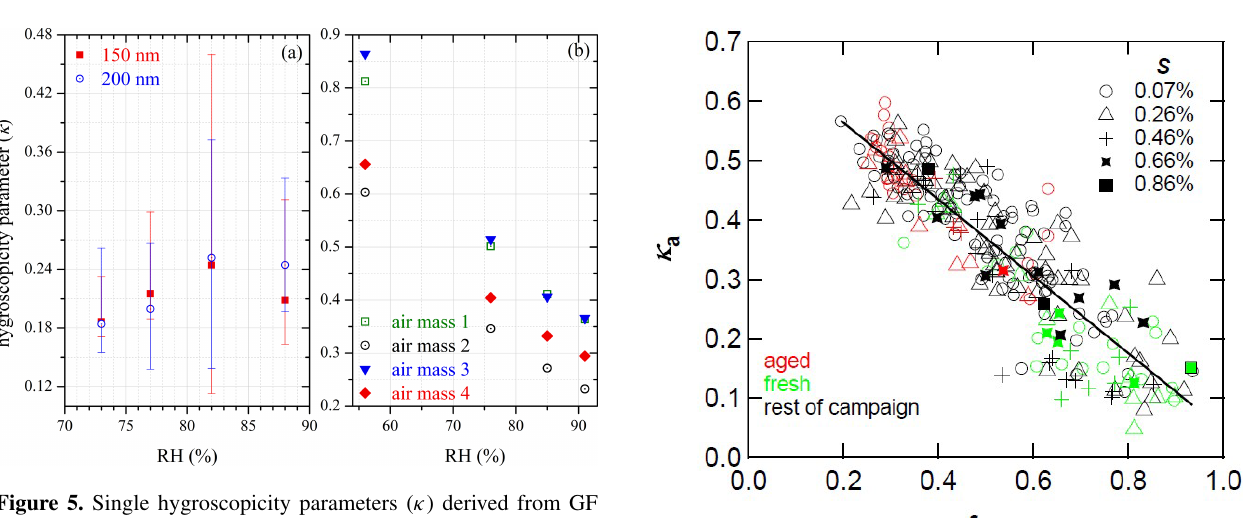
Figure 5. Single hygroscopicity parameters ( κ ) derived from GF measured at different RHs. (a) 150 and 200nm particles at the ZJU site (Hangzhou) in December 2009–January 2010 (Zhang et al., 2011); (b) 250nm particles at the Yufa site (Beijing) in August– September 2006 for four typical air masses (Achtert et al., 2009). Error bars are not shown in (b) as uncertainties are not provided in the original paper.